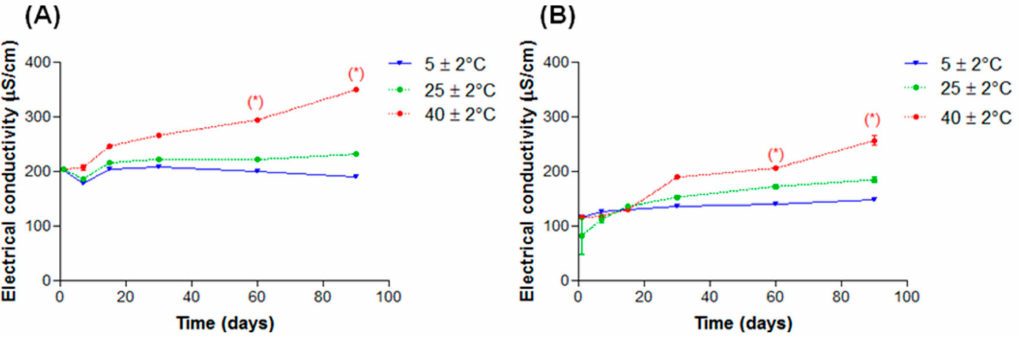
Figure 11. Electrical conductivity in function of time of nanoemulsions subjected to different storage temperatures, ( A ) EL and ( B ) AL. * p <